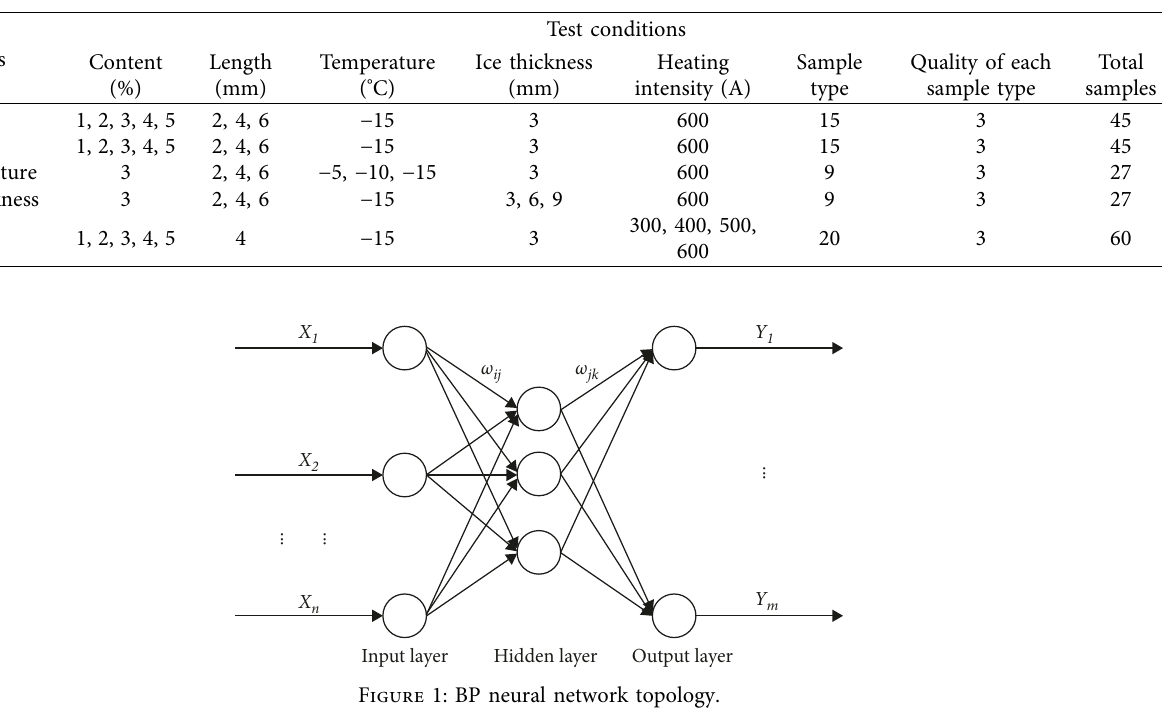
Table 6: Information of ice-melting tests.